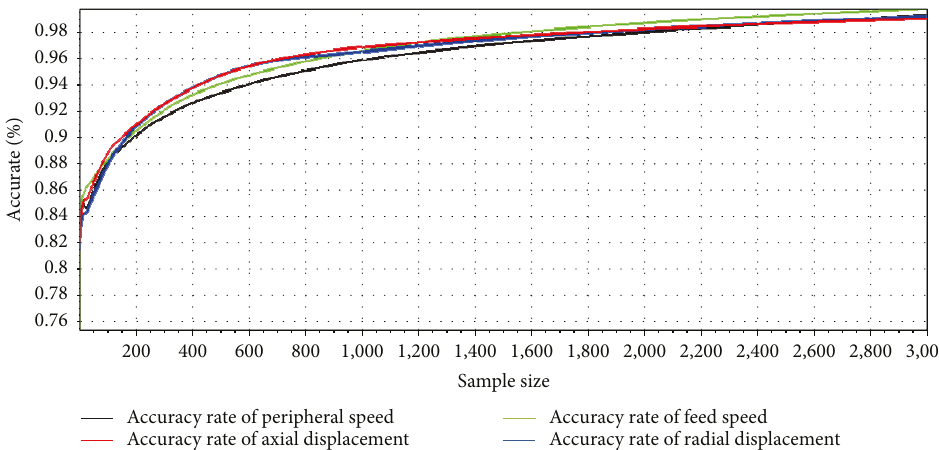
Figure 13: Trends of accuracy changing of deep learning neuron network for casting block grinding with samples increasing.